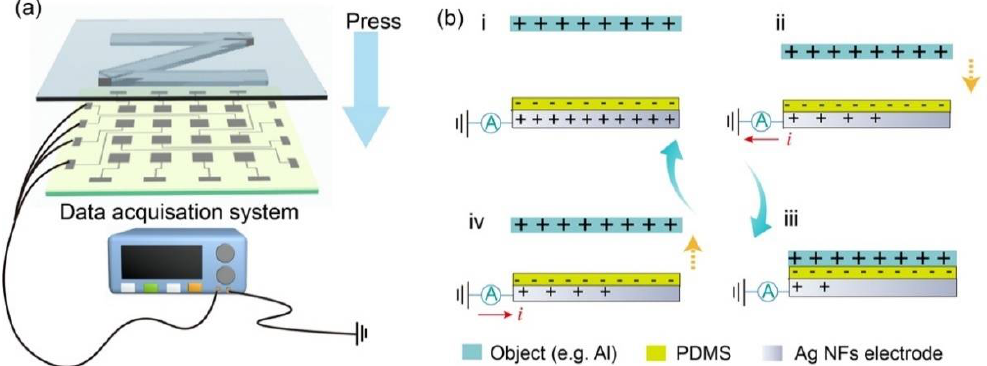
Figure 4. The pressure mapping test and the working principle. ( a ) Each pixel is connected to the data acquisition equipment through leading wire, and sensing data are collected from electrometers. When the stamp is pressed on to the pixel array, the output signal from pixels contacting the stamp ridges increases to differentiate the stamp shape. ( b ) Description of the working mechanism of the single electrode TENG pressure sensor. ( i ) The original state where the object is away from the sensor, the sensor is at the electrostatic equilibrium state. ( ii ) When the object with positive charges gets close to the sensor, to keep the electrostatic equilibrium state, the positive charges at the electrode interface decreases, resulting in a current from the sensor electrode to the external circuit until fully contacted. ( iii ) When the object is fully contacted with the sensor surface, the sensor reaches another static equilibrium state. ( iv ) When the object moves away from the sensor, an opposite process of ( ii ) happens, to maintain the electrostatic equilibrium state with positive charges being away from the PDMS surface, positive charges move from external circuit towards the sensor electrode.